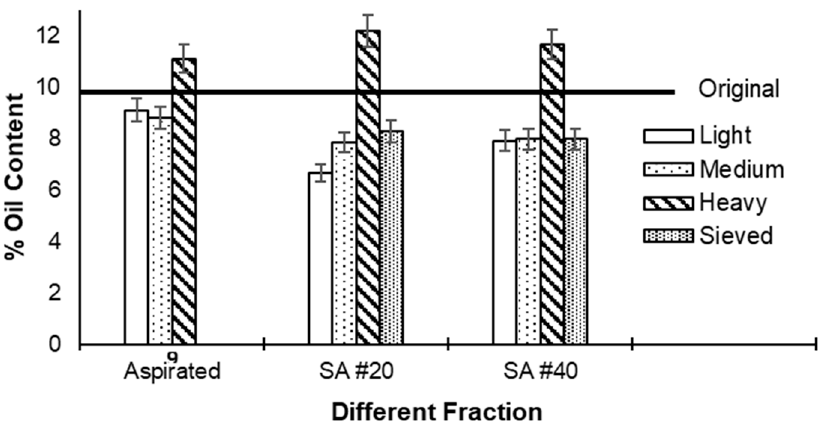
Figure 2. Oil content variation of the different fractions.